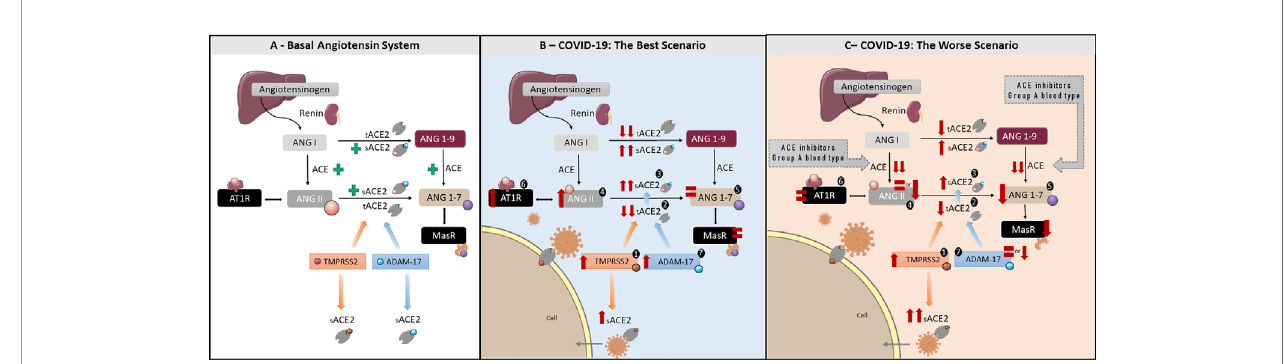
FIGURE 1 | The roles of the RAAS in health and COVID-19: A better and worse scenarios — (A) Basal angiotensin system. Figure representing the classic RAAS pathway. Angiotensin I (ANG I) is produced from angiotensinogen by renin. ANG I is converted to Angiotensin II (ANG II) by Angiotensin-Converting Enzyme (ACE). ANG II exerts its actions by binding to AT1R. Angiotensin-Converting Enzyme 2 (ACE2), is responsible for converting ANG I to Angiotensin 1-9 (ANG 1-9) and ANG II to Angiotensin 1-7 (ANG 1-7). ANG 1-7 has opposite effects to ANG II, counterbalancing ANG II physiological outcome. ADAM 17 and TPMRSS2 are sheddases responsible for cleaving tACE2 into its soluble form, sACE2. ADAM17 cleaves tACE2 in a constitutively manner, while TMPRSS2 is implicated in SARS-CoV-2 infection, supporting virus entry the cell host. (B) COVID-19 Best Scenario (for a better understanding, follow the order of numbers). Increased TMPRSS2 activity due to viral entry resulting in reduced tACE2 and consequent increase in sACE2, unable to convert ANG II in ANG 1-7. This will lead to increased ANG II levels, and increased AT1R activation, resulting in higher ADAM-17 activity. Higher ADAM-17 activity will increase biologically active sACE2 levels, able to convert ANG II in ANG 1-7, resulting in no alteration in ANG 1-7 levels. In this scenario, the intense tACE2 cleavage promoted by ANG II/AT1R/ADAM-17 axis will reduce virus entry into the cells. (C) COVID-19 Worst Scenario Note that this scenario is closely related to an incapacity in promote the ANG II peak or AT1R down-regulation, as suggested to the use of ACE inhibitors, genetic factors (i.e. A blood type), diabetes mellitus and cardiovascular diseases. (for a better understanding, follow the order of numbers). Increased TMPRSS2 activity due to viral entry resulting in a mild reduction tACE2 as well as a mild increase in sACE2, unable to convert ANG II into ANG 1-7. Consequently, ANG II levels will remain equal or even decrease, as well as AT1R activation, and resulting in ANG 1-7 decrease. In this scenario, the equal or low levels of ANG II, AT1R, and ADAM-17 activities will be associated to a mild decrease in tACE2 and a substantial increase in sACE2 produced by TPMRSS2, increasing the virus entry into the